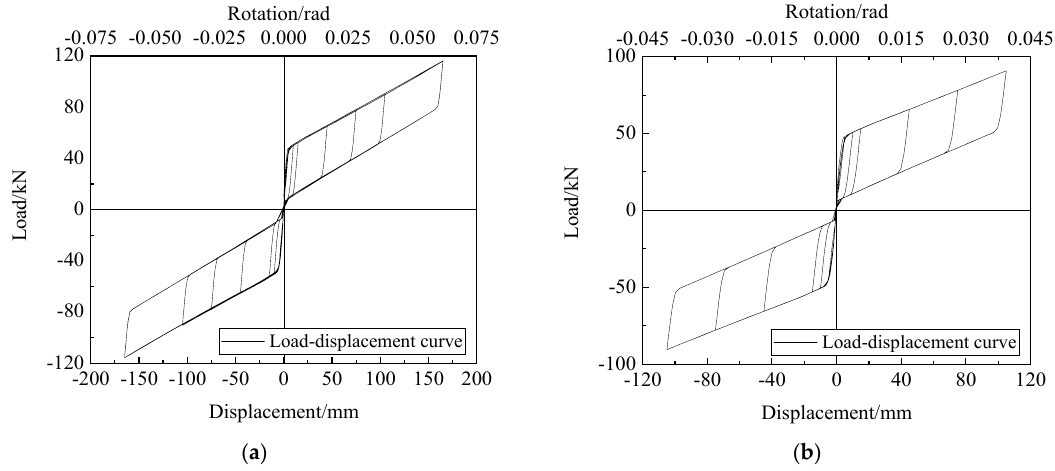
Figure 10. Load–displacement curves: ( a ) Maximum joint rotation of 0.06 rad; ( b ) Maximum joint rotation of 0.04 rad.